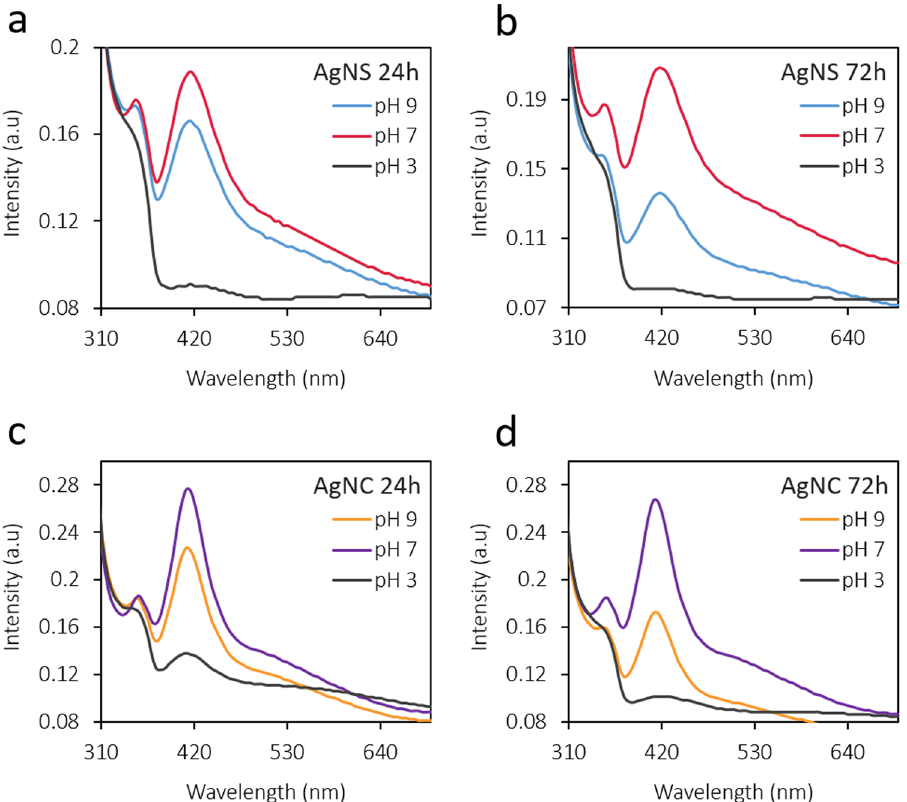
Figure 4. UV-visible spectral changes for nanoparticles in different pH conditions: ( a , b ) AgNS and ( c , d )